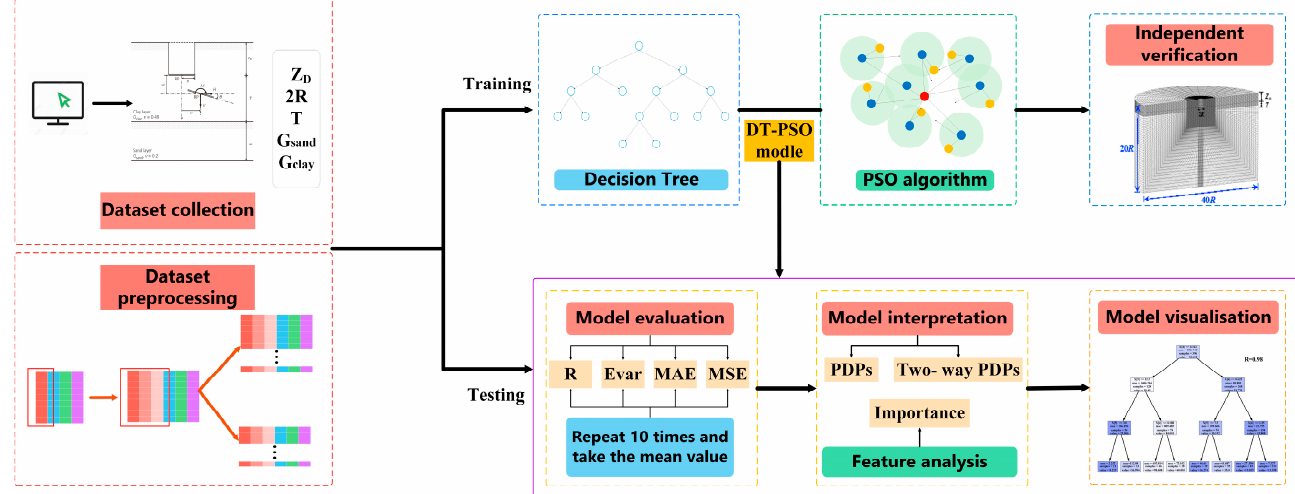
Figure 1. The adopted methodology of this work.